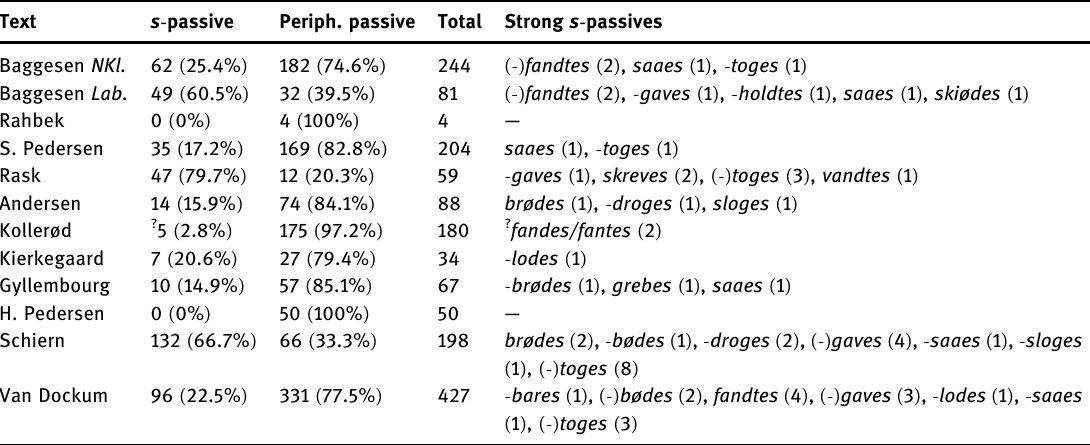
Table 6: Past - tense passives in the corpus Text